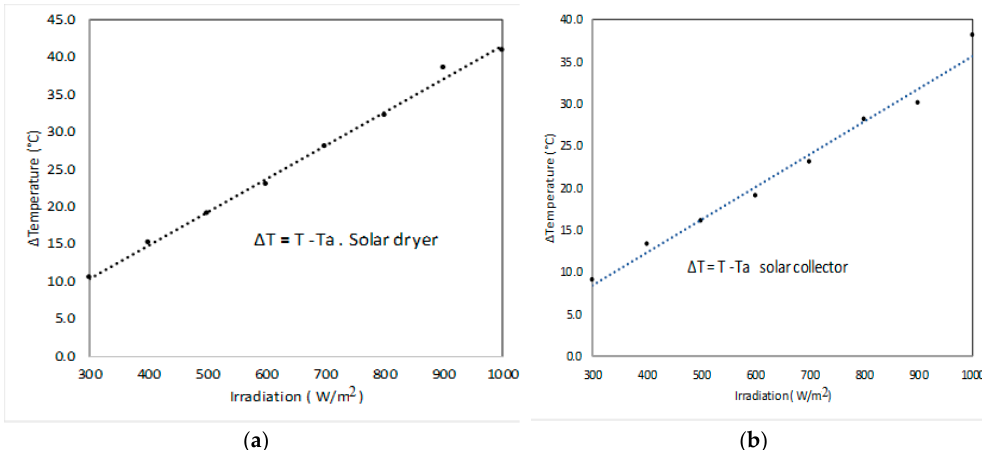
Figure 3. Difference between the internal temperature and the ambient temperature vs. irradiation in the ( a ) drying chamber, and ( b ) solar